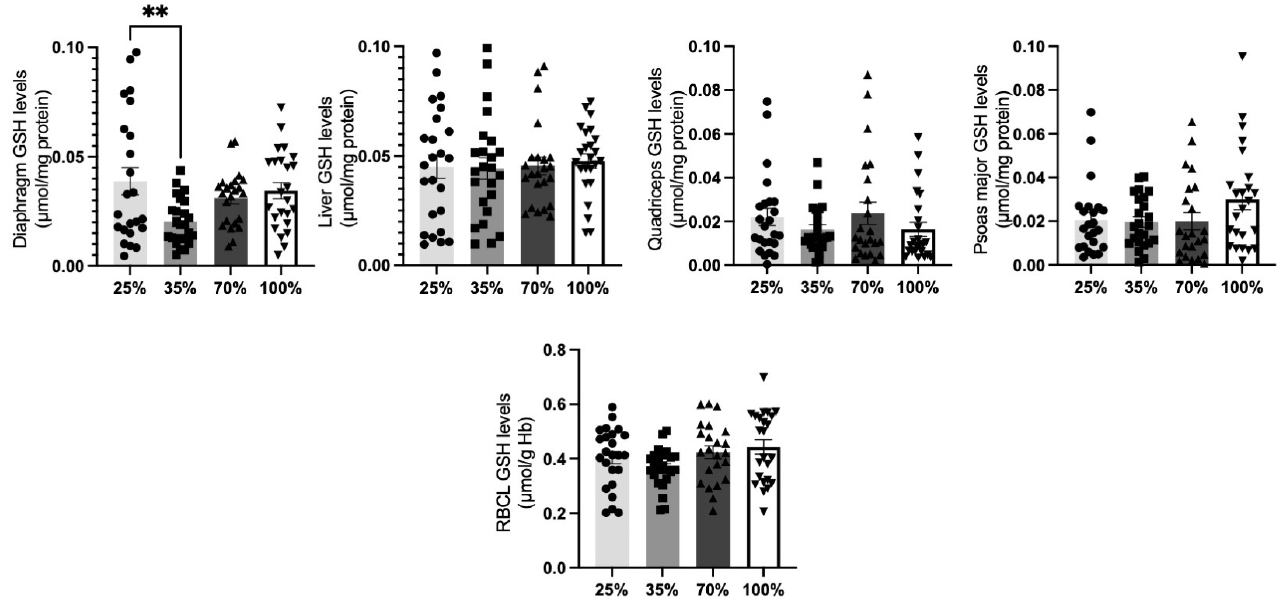
Figure 6 . GSH levels at all 4 d.s. of lambs . ** denotes significant difference with p < 0.01. Figure 6. GSH levels at all 4 d.s. of lambs. ** denotes significant difference with p < 0.01.